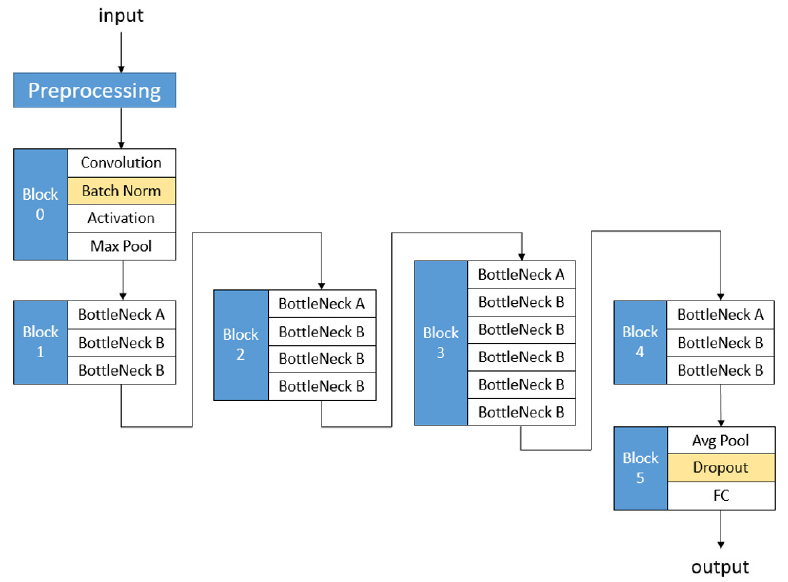
Figure 9. Architecture for traditional ResNet-50 with addition of dropout layer. Details in bottleneck A and B are shown below.